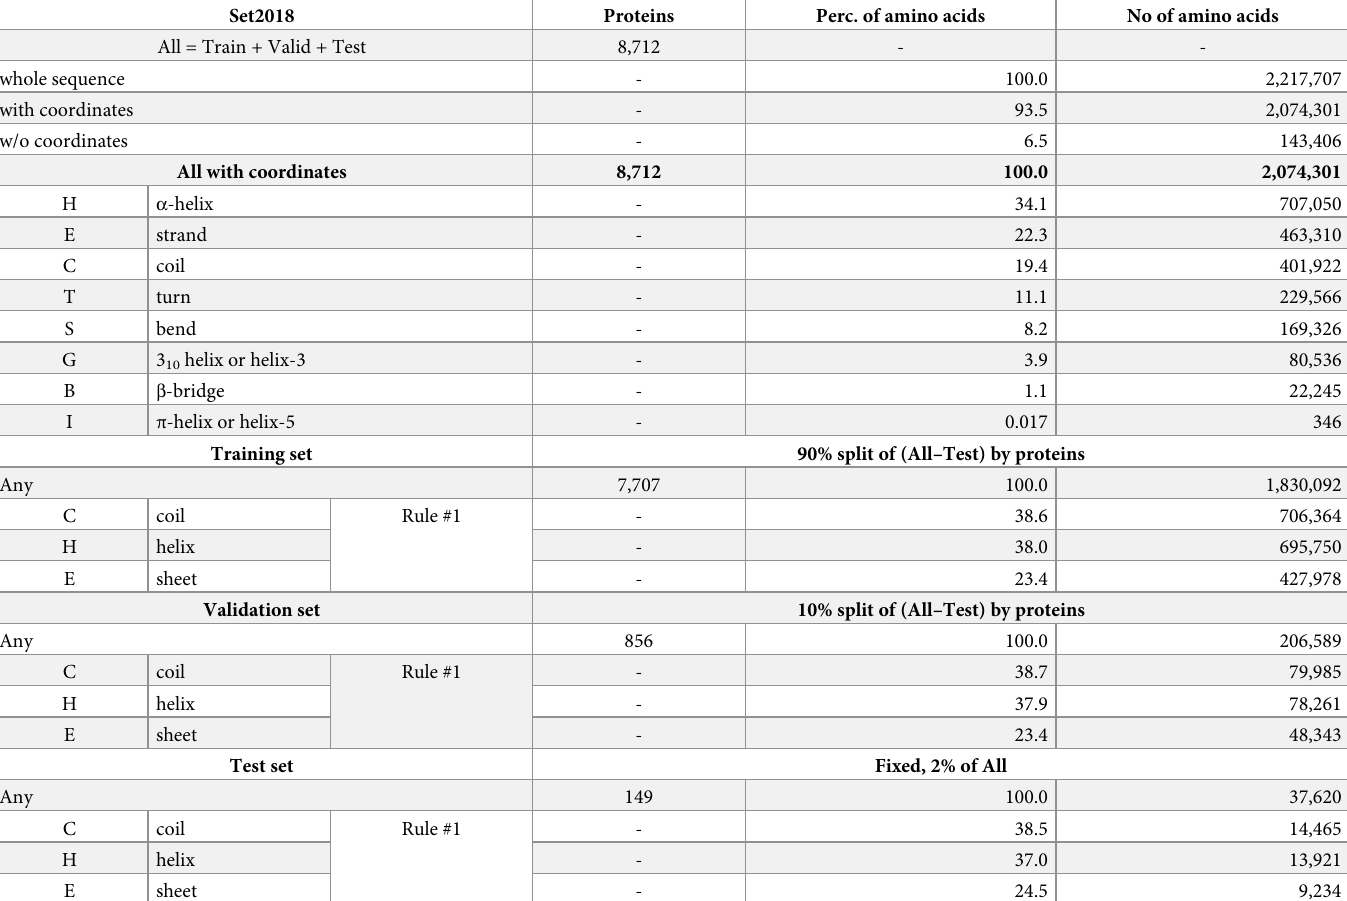
Table 1. Statistics for the Set2018 training, validation, and testing data sets.